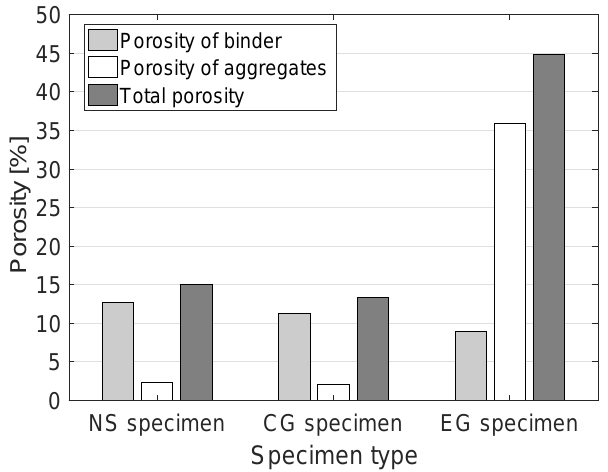
Figure 9. Porosity data of each phase in the specimens (Note: the total porosity values of each case are 15.1%, 13.4%, and 44.8% for NS, CG, and EG specimens,